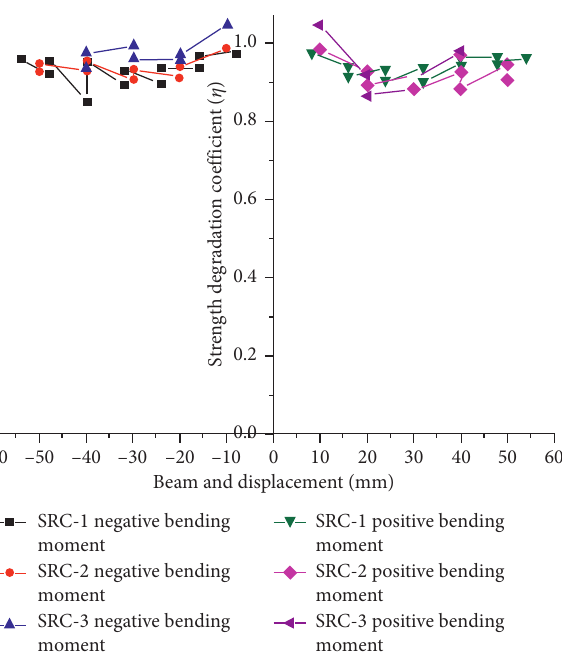
Figure 14: Strength degradation coefficient.